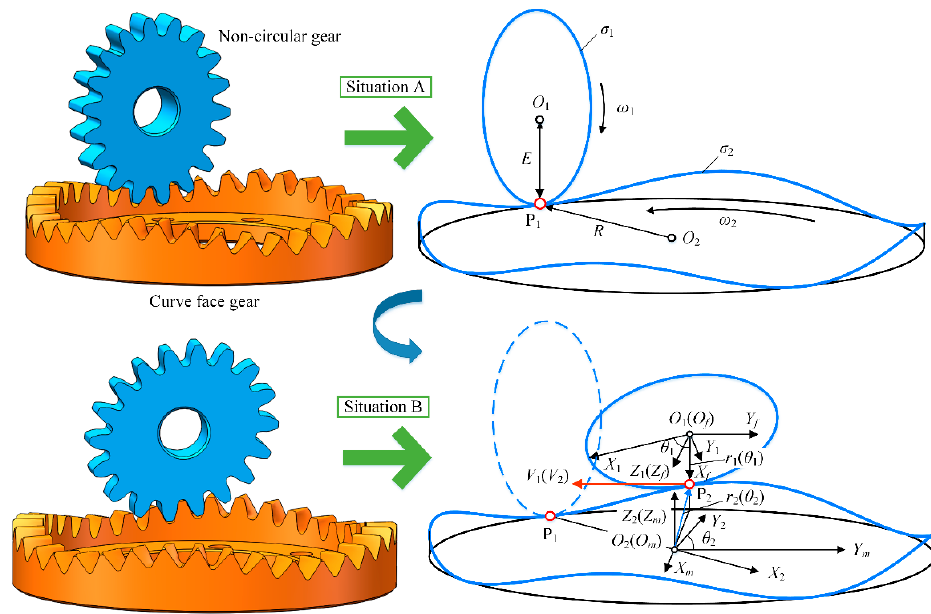
12 of 23 Figure 9. Tooth profile classification of curve face gear pair. 4.1. Transmission Principle and Pitch Curve According to the gear meshing principle, the pitch curve of the curve face gear pair is independent of the tooth profile. Figure 10 is the meshing coordinate system of the pitch